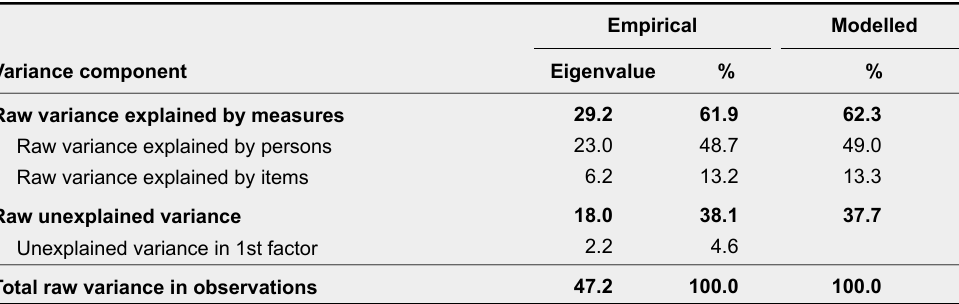
Standardised Residual Variance in Eigenvalue